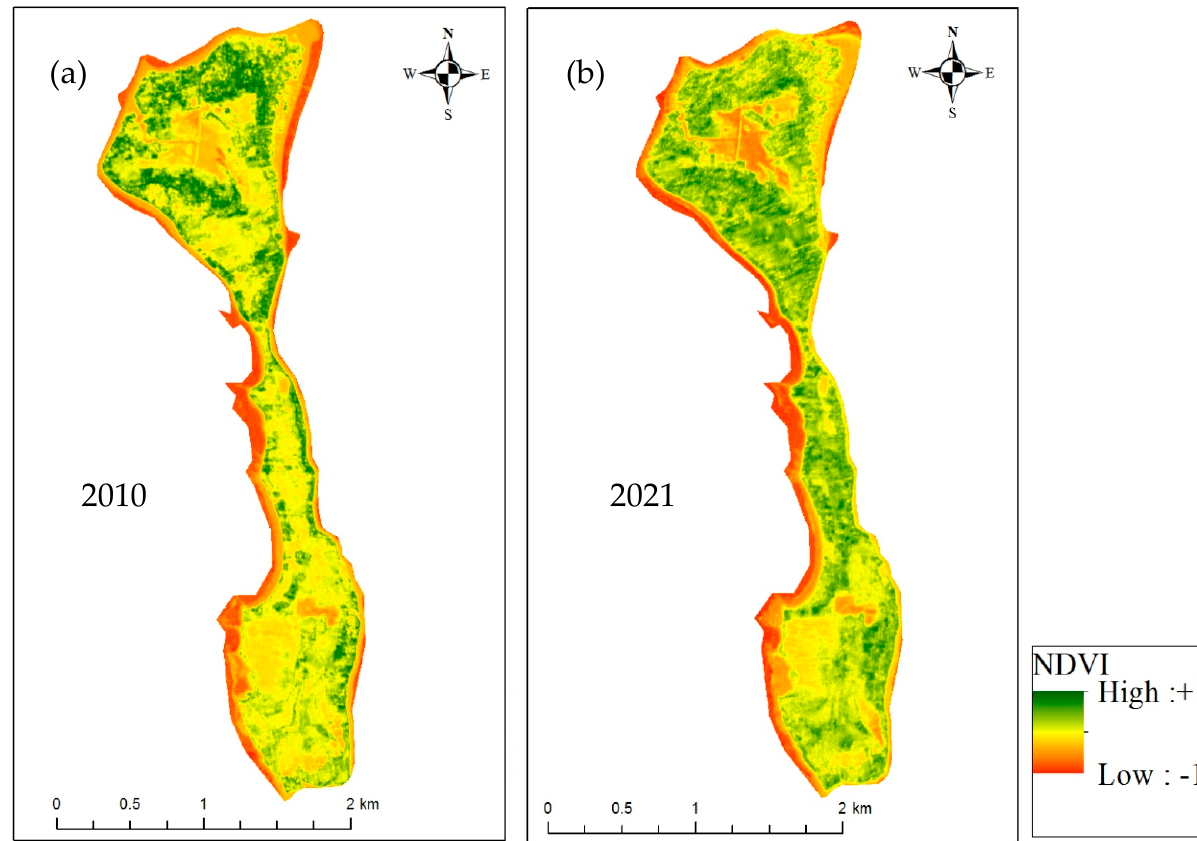
Figure 8. ( a ) NDVI index of Saint Martin’s Island, 2010. ( b ) NDVI index of Saint Martin’s Island, 2021.